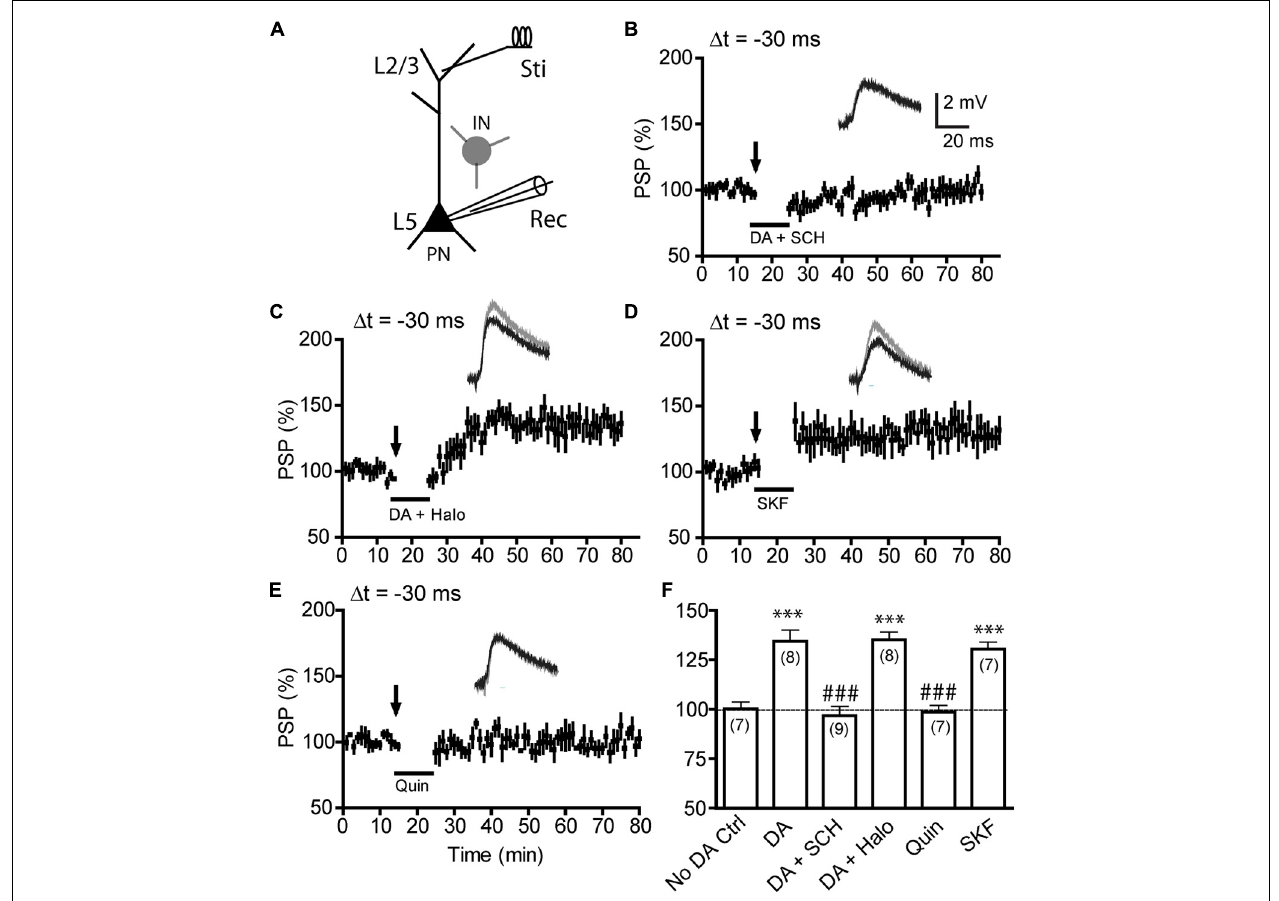
FIGURE 2 | Dopamine-enabled t-LTP at negative-timing depends on D1Rs, but not D2Rs and can be induced under intact GABAergic transmission by D1R, but not D2R, activation. (A) All experiments in this figure were done with picrotoxin omitted in the bath to preserve GABAergic inhibitory transmission. (B,C) Effects of the D1R antagonist SCH23390 (SCH, 10 μ M; B ) and the D2R antagonist haloperidol (Halo, 2 μ M; C ) on DA-enabled t-LTP at Δ t = − 30 ms. DA enabled t-LTP was